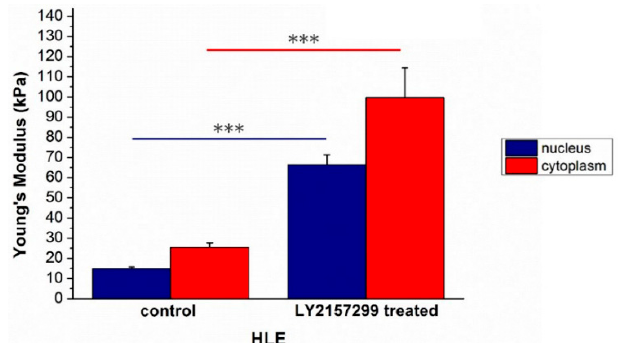
Figure 6. The Young’s modulus values with standard deviation, calculated from the nuclear region and the cytoskeletal area respectively, were reported for HLE CTR and HLE LY2157299 cells. Results were statistically significant for p < 0.005 (indicated as ***).